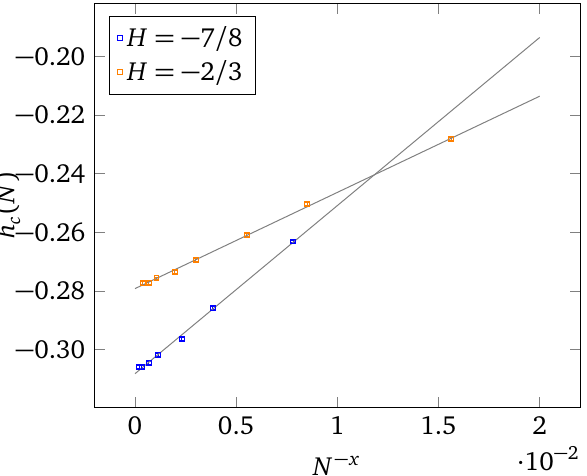
( N ) obtained from the crossing of the curves r Bin Figure 19: Values of h c ( h ) , defined in (58). Measurements have been taken for the surface r Bin N